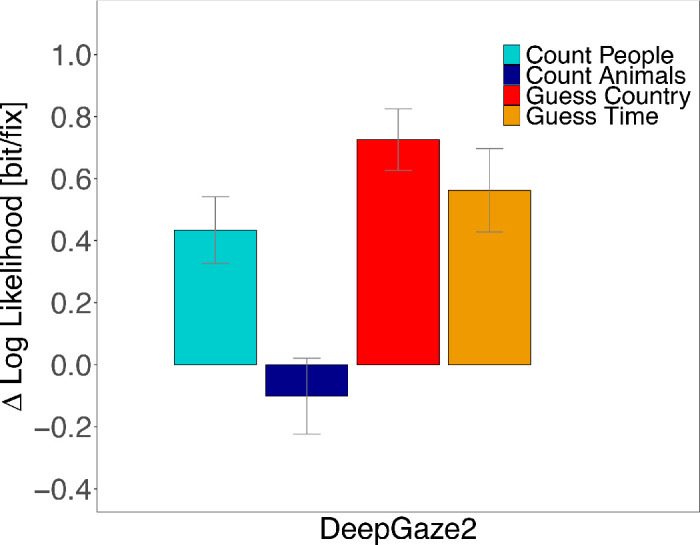
Average predictability of fixation locations in each task by the DeepGaze2 model. Predictability was measured in bit per fixation as the average gain in log-likelihood of each fixation relative to a uniform distribution. Confidence intervals were corrected for within-subject designs (Cousineau, 2005; Morey, 2008).